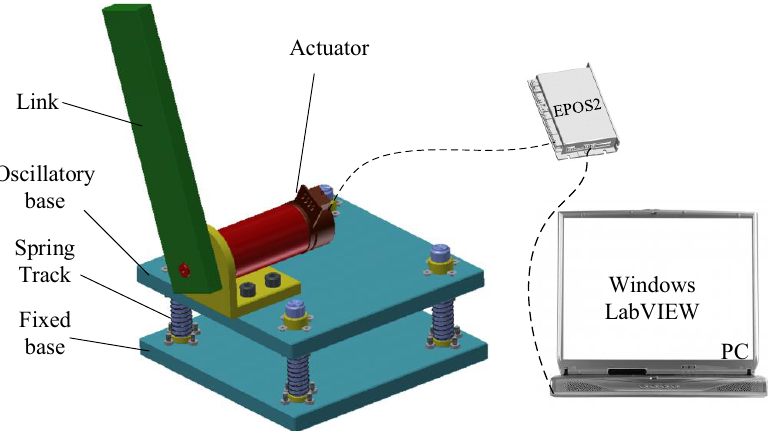
Figure 3. Principle of the experiment platform. The system parameters are: J 2 = 0.009 kg · m 2 , m 2 = 1.38 kg, a 2 = 0.14 m, L 2 = 0.26